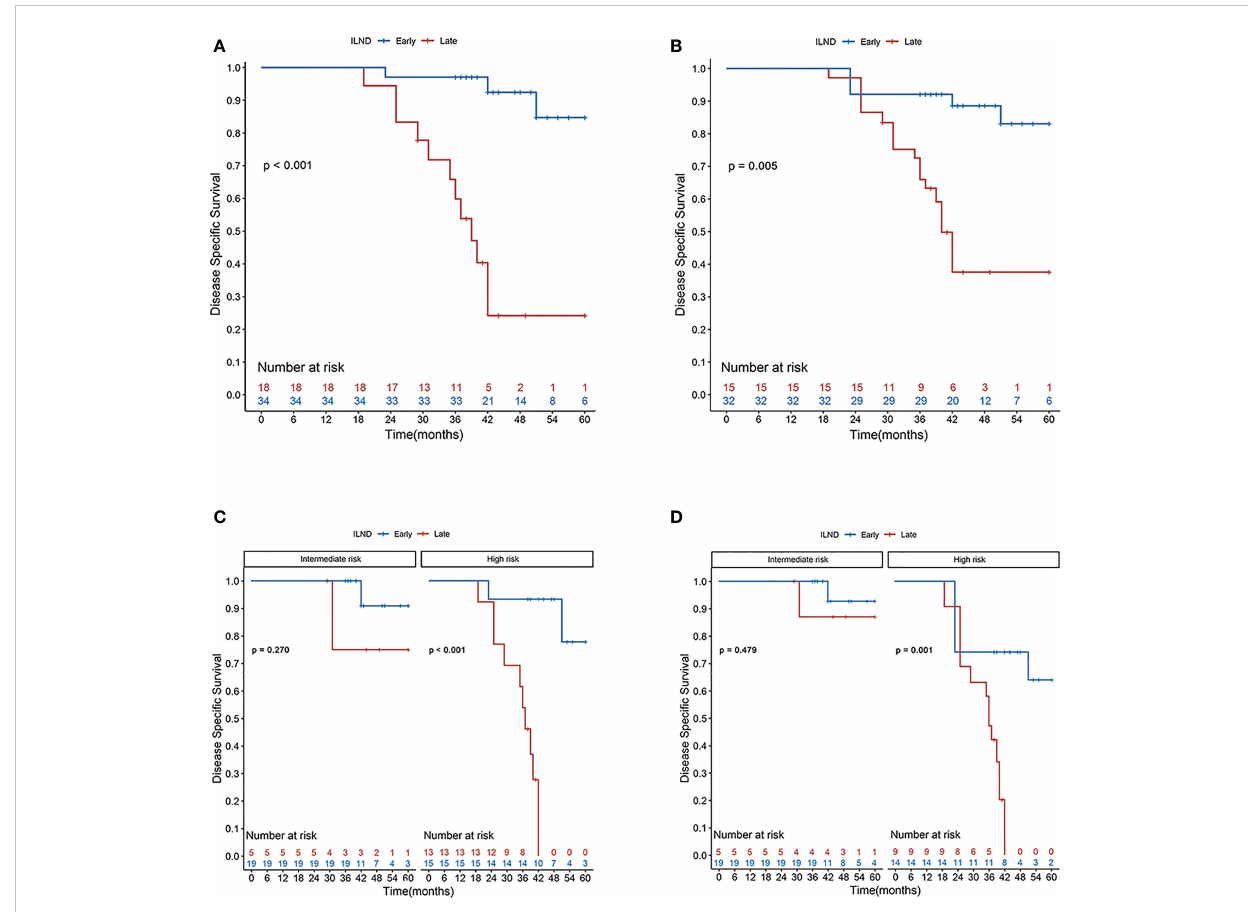
FIGURE 3 Disease-speci fi c survival rates according to the Kaplan – Meier curves in patients undergoing early (blue line) and late (red line) inguinal lymph node dissection: (A) primary cohort; (B) cohort after S-IPTW adjustment; (C) primary cohort strati fi ed by risk level; and (D) cohort strati fi ed by risk level after S-IPTW